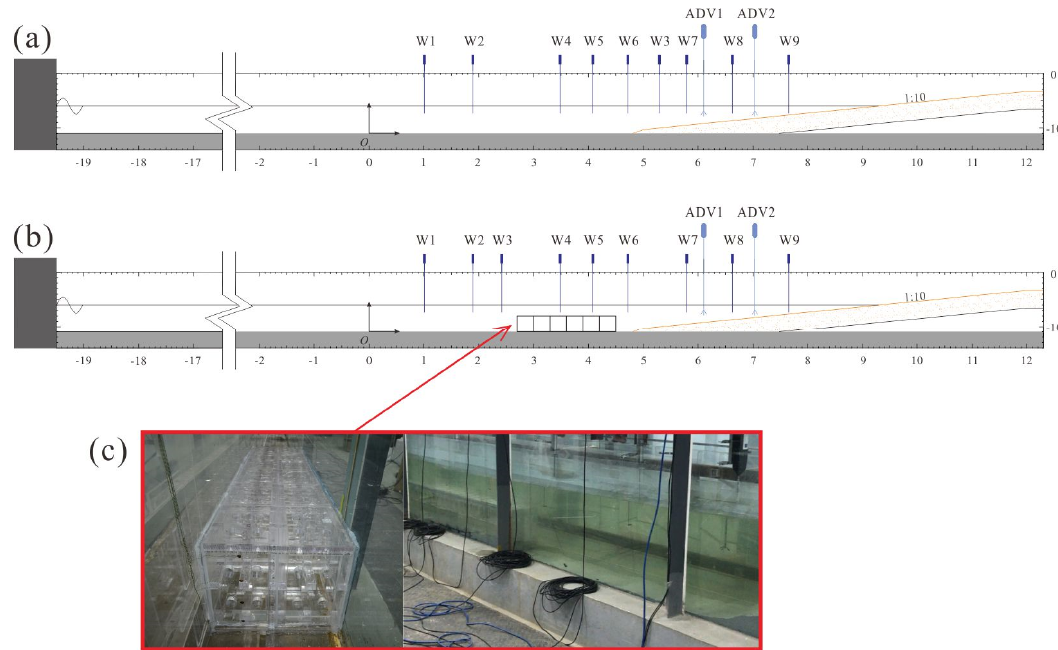
Figure 2. Experimental setup: ( a ) side-view layout for natural beach (profile type B); ( b ) the AR protected beach (profile type B-AR); ( c ) photo of the model AR in the flume.